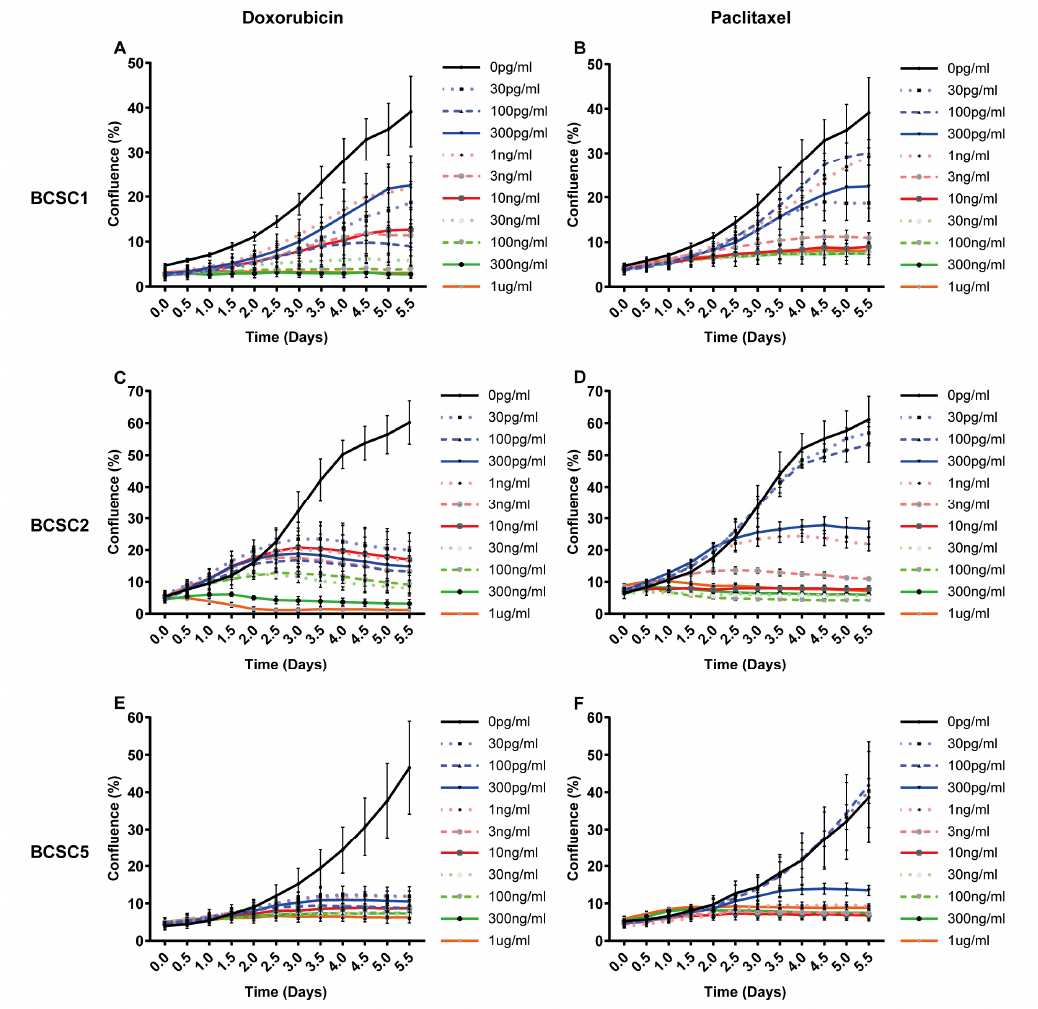
Figure 2. BCSCs from TNBC show different resistance against doxorubicin and paclitaxel. BCSCs were treated with doxorubicin and paclitaxel at 10 different concentrations ranging from 30 pg/mL to 1 μ g/mL. Cell confluence was recorded and analyzed using automated phase contrast microscopy. ( A ) Dose response curves over time for BCSC1 under doxorubicin, ( B ) BCSC1 under paclitaxel ( C